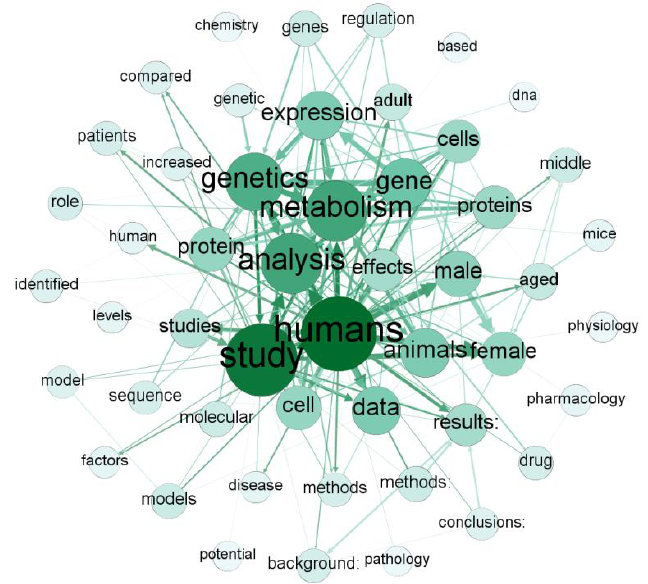
Figure 2. Co-occurrence network of high-frequency words within the bioinformatics literature ( K = 500, E = 200).